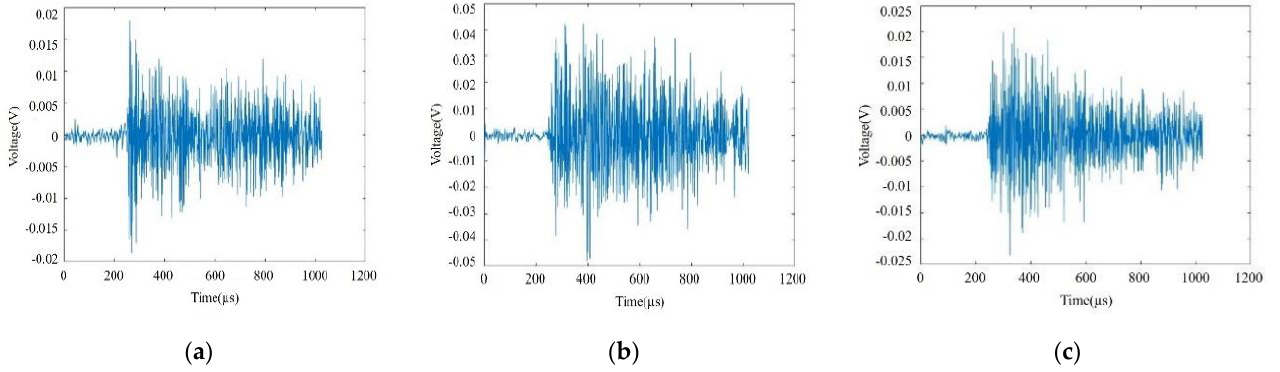
Figure 9. Time domain waveform of the P-signals of each sample. ( a ) A1.No.17715, ( b ) B1.No.8200, ( c ) C1.No.6375.